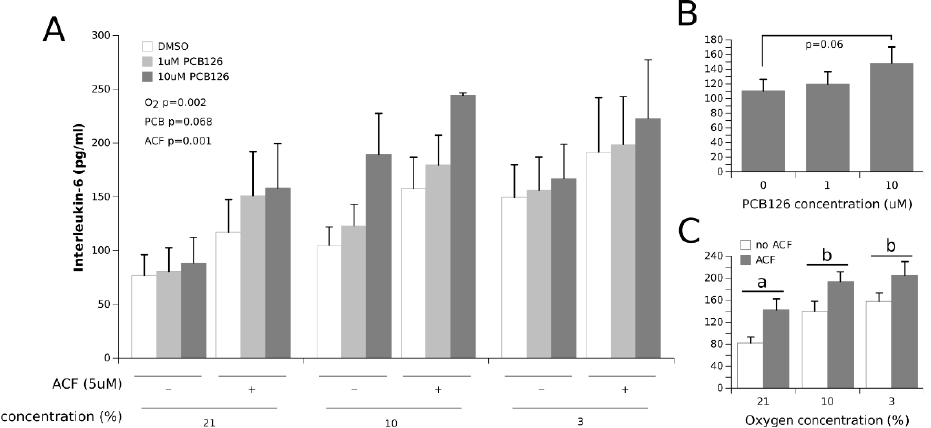
Figure 5. Effect of PCB126 and hypoxia on the media IL-6 concentration in human adipocytes. Adipocytes were treated with DMSO (vector) or 1 and 10 µM PCB126 for 24 h, then subjected to 21, 10 or 3% O 2 for another 24 h. Acriflavine (ACF) 5 µM was used as an HIF 1α -inhibitor. Panel ( A ) illustrates the whole model. Markers of statistical difference for individual bars were omitted due to the complexity of the model. Panel ( B ) summarizes the trend between 0 and 10 µM PCB126 on media IL-6 concentrations. Panel ( C ) summarizes the effects of hypoxia and ACF treatment on media IL-6 concentrations. In panel C, pairs of bars (representing the main effect of oxygen) not sharing a common letter are statistically different at p < 0.05. Each bar represents the mean ± SEM of three separate experiments for each treatment group.